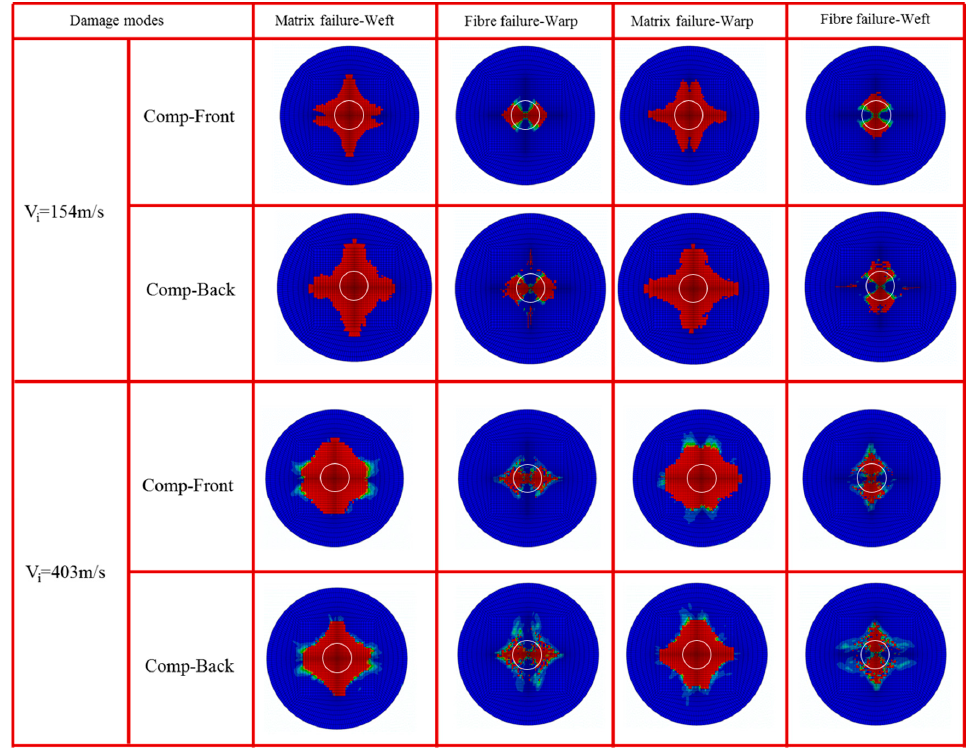
Figure 12. Fibre and matrix failure mode shape of the TFML 3/2 target.